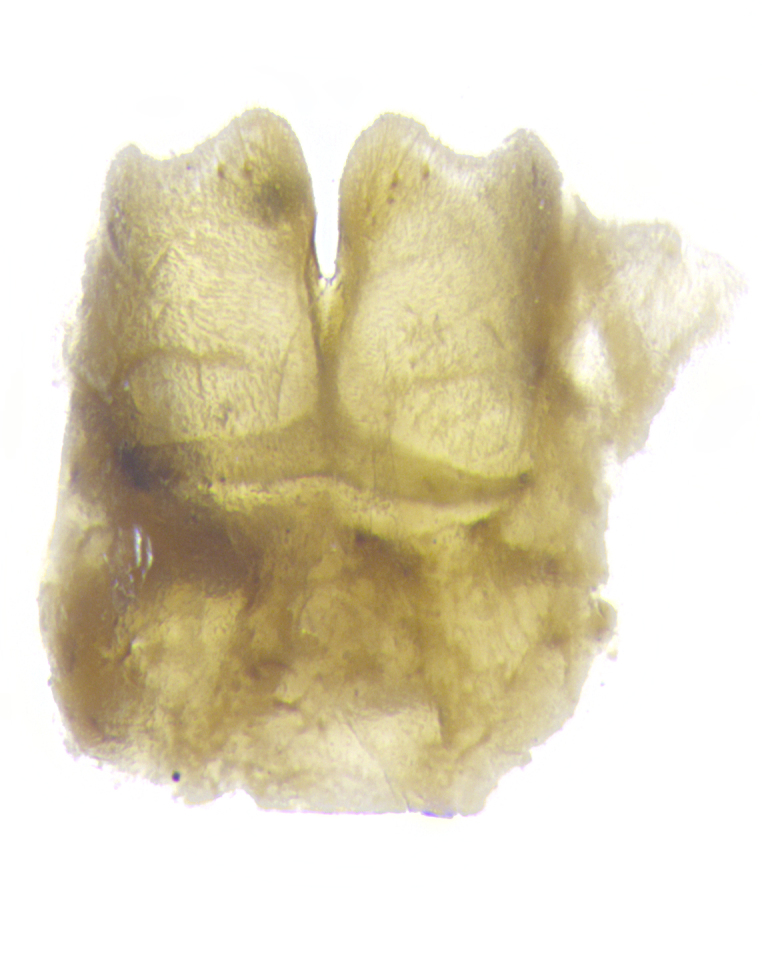
sternite 5, ventral view.